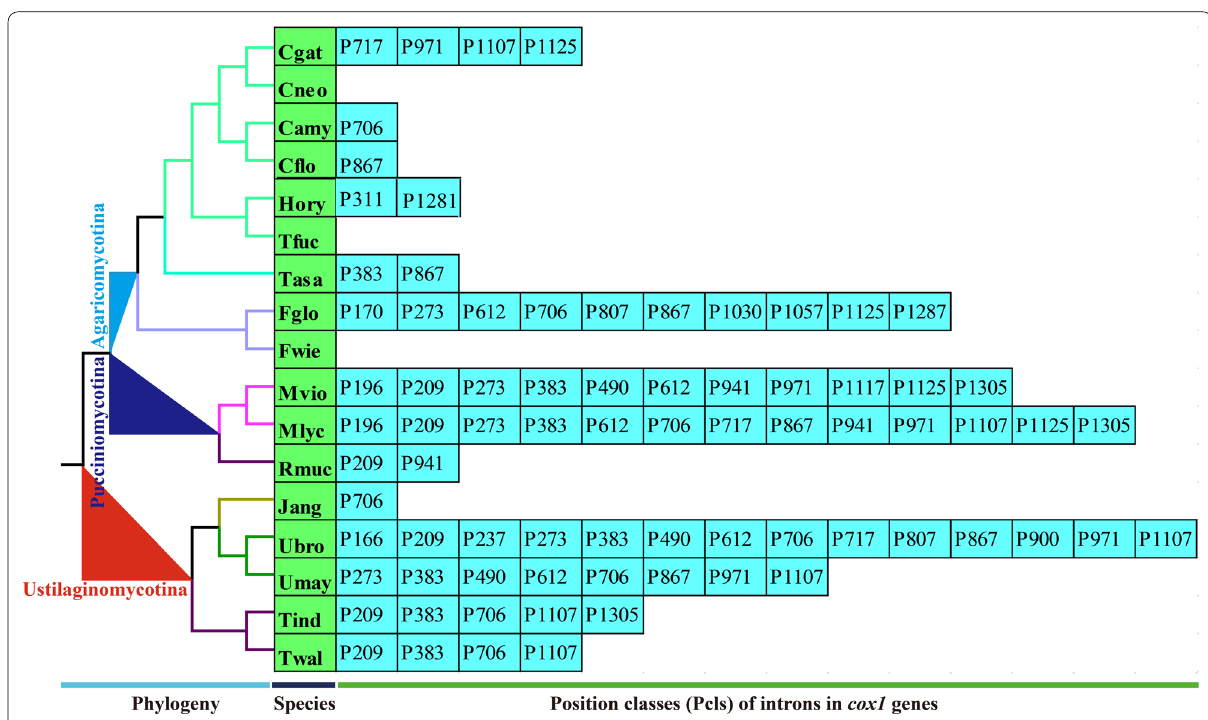
Fig. 5 Position class (Pcl) information of cox1 genes. Introns in cox1 genes of 17 mitogenomes from Agaricomycotina , Pucciniomycotina and Ustilaginomycotina were classified into different position classes (Pcls) using the cox1 gene of Ganoderma calidophilum as the reference. Each Pcl was constituted by introns inserted at the same position of corresponding cox1 gene and named according to its insertion site in the aligned corresponding reference sequence (nt). The Pcls present in more than 1/5 of the 17 mitogenomes were considered as common Pcls, while introns detected in less than 1/5 of species were considered to be rare introns. Phylogenetic positions of the 17 species were established using the Bayesian inference (BI) method and Maximum Likelihood (ML) method based on concatenated mitochondrial genes. Species information is shown in Additional file 1: Table